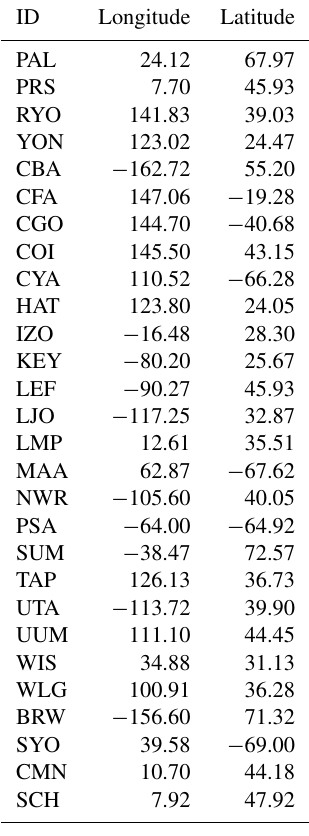
Table B2. CO 2 stations used for evaluation that have not been used as constraints for the